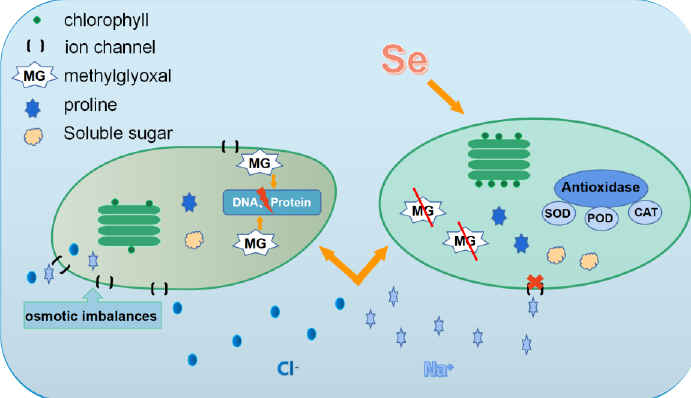
Figure 3. Patterns of Se mitigating salt stress in plants. The left shows plant cells under Na + salt stress. The right shows a cell treated with Se under salt stress.